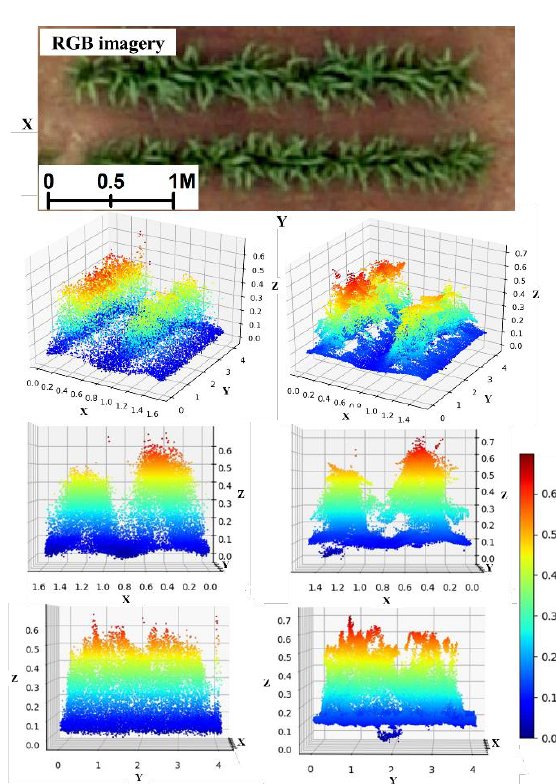
Figure 6. 3D visualization of one selected plot in L-field. (a), (c), (e) are perspective and side views of LiDAR point clouds; (b), (d), (f) are perspective and side views of RGB photogrammetry point